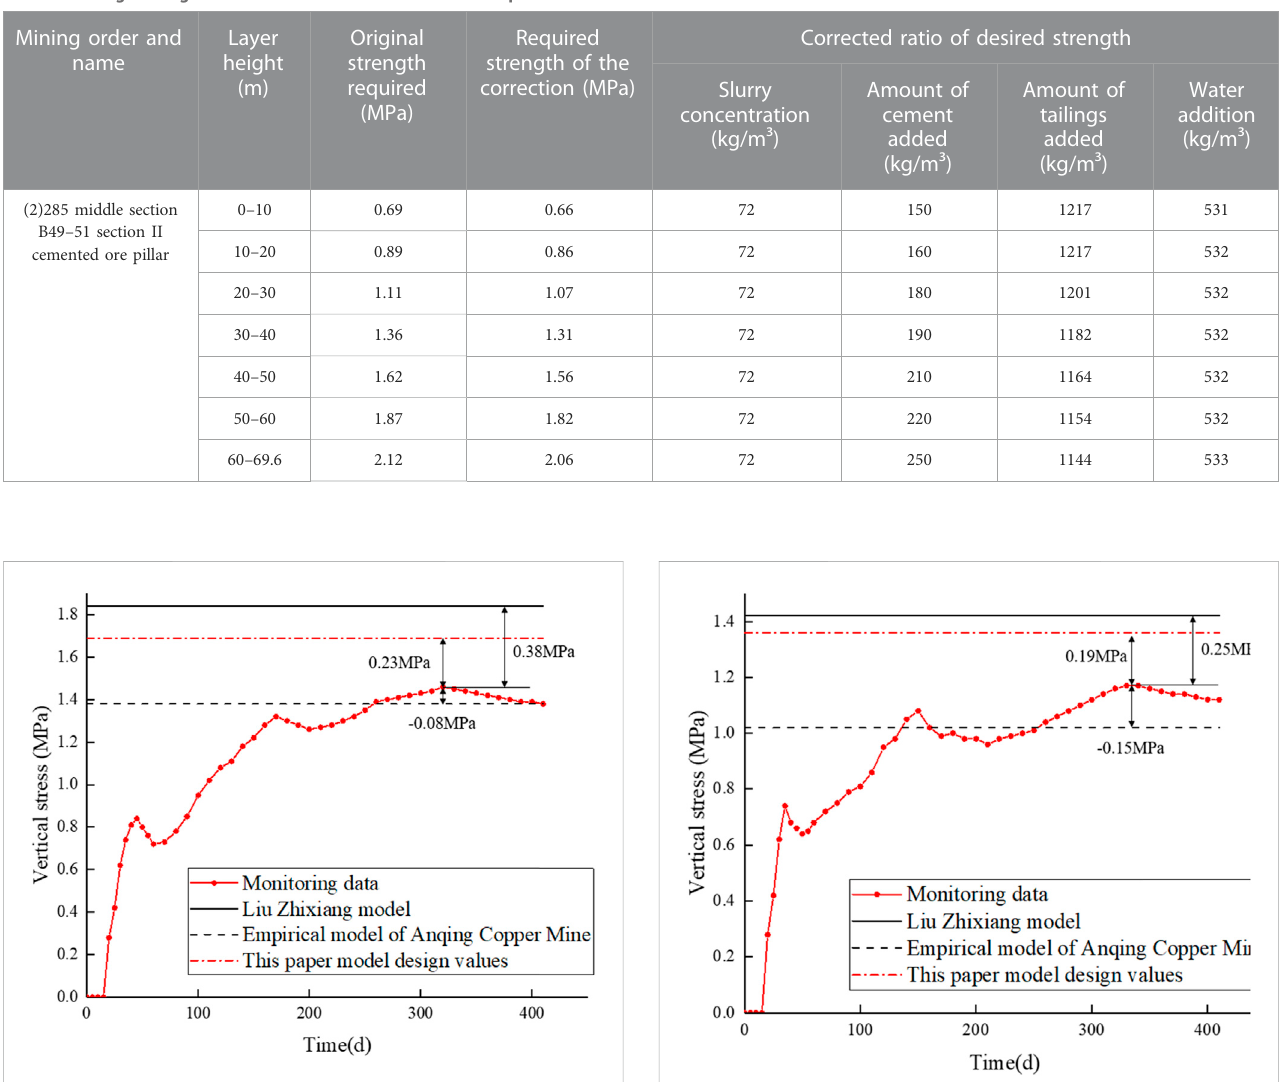
FIGURE 16 Curve showing changes in #9 pressure cell monitoring data with time.